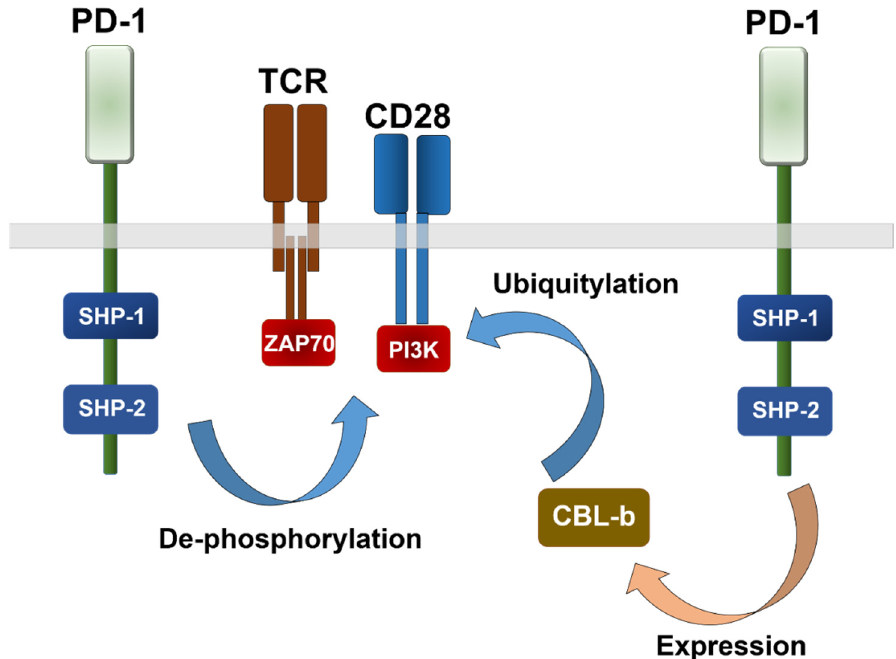
Figure 1. The two main inhibitory pathways of PD-1. A schematic representation of the two main inhibitory pathways regulated by PD-1 in T cells leading to T cell inactivation. On the left, PD-1 after engagement with PD-L1 recruits SHP phosphatases which de-phosphorylate ZAP70, PI3K and additional TCR-dependent signaling kinases. On the right, PD-1 up-regulates the transcriptional expression of the E3 ubiquitin ligase CBL-b, which ubiquitylates components of the TCR signalosome, leading to its internalization and degradation. Table 1. FDA-approved PD-L1/PD-1 blocking